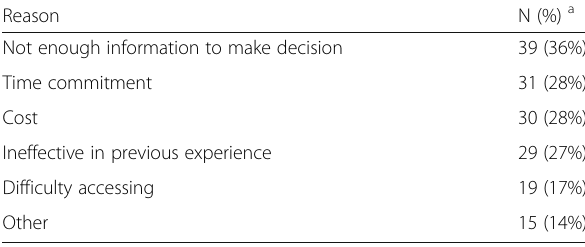
listed most to least commonly reported